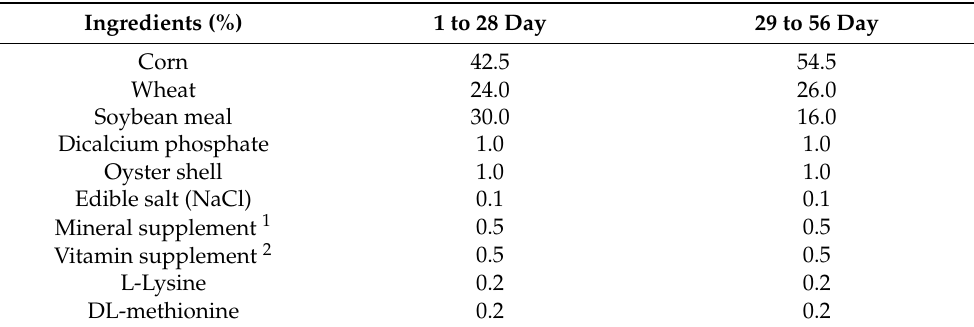
Table 1. Composition and nutrient levels of the basal